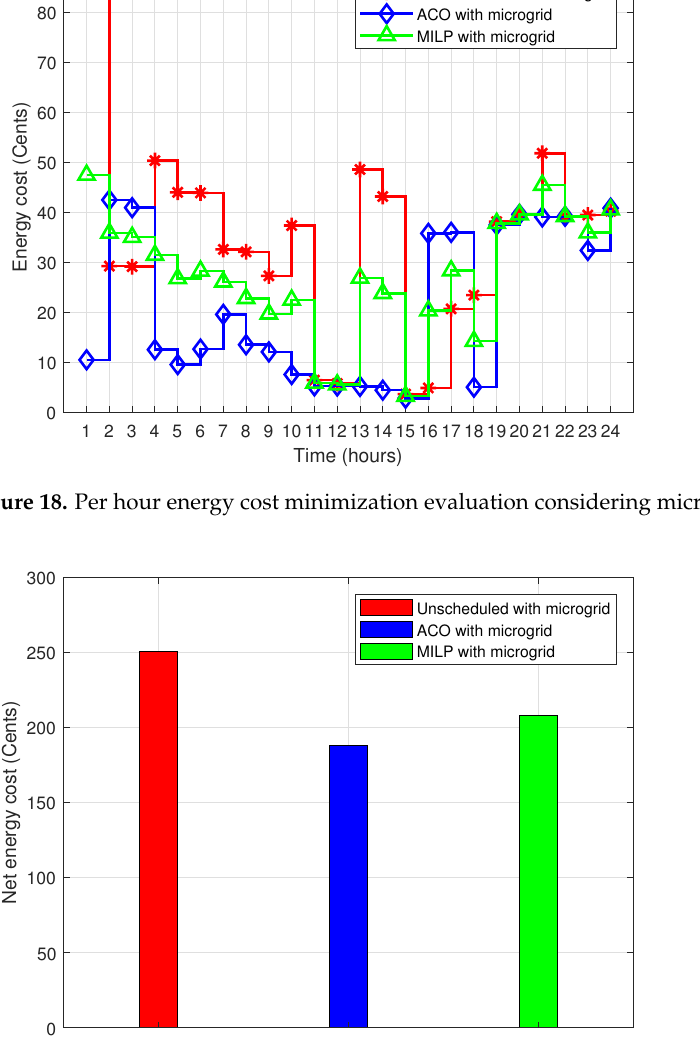
Figure 19. Net Energy cost minimization evaluation considering